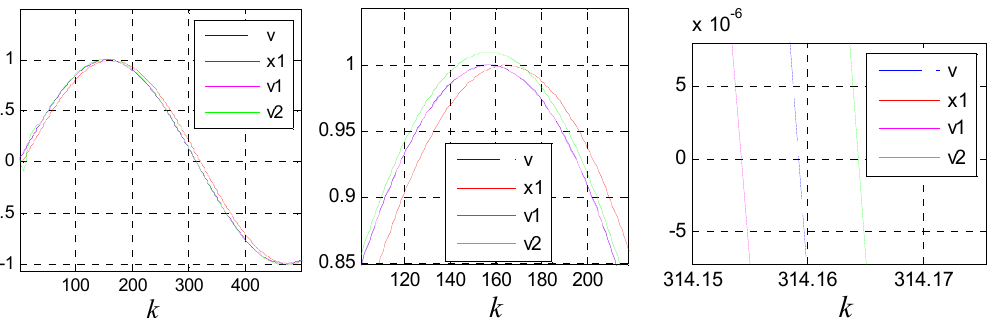
( k ) with different scale. 1